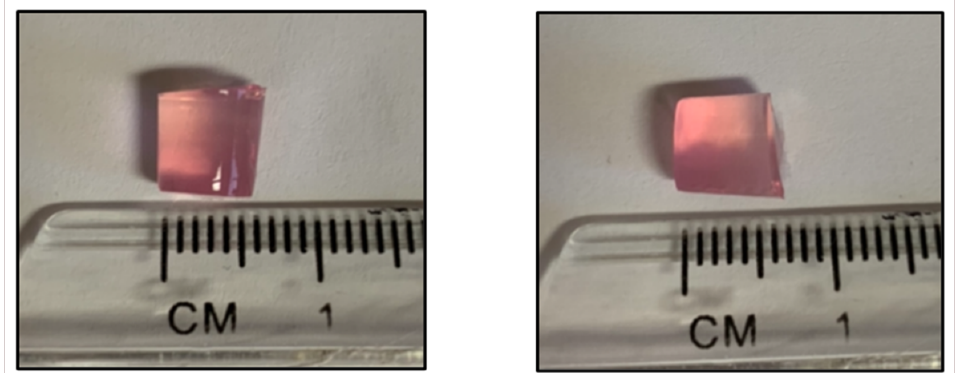
Figure 6. Representative images of a chondrocyte-agarose scaffold removed from the 24-well inserts in the co-culture model for